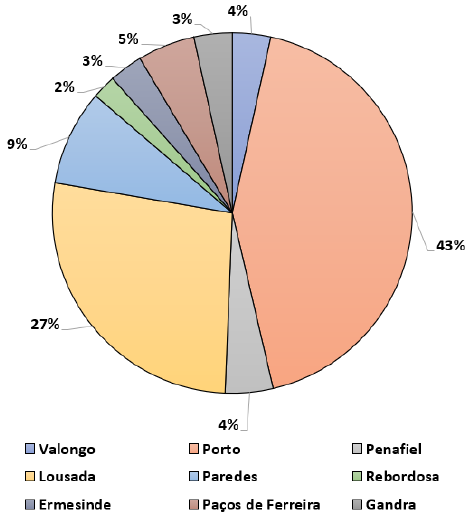
Figure 5. Geographical distribution of members by region.